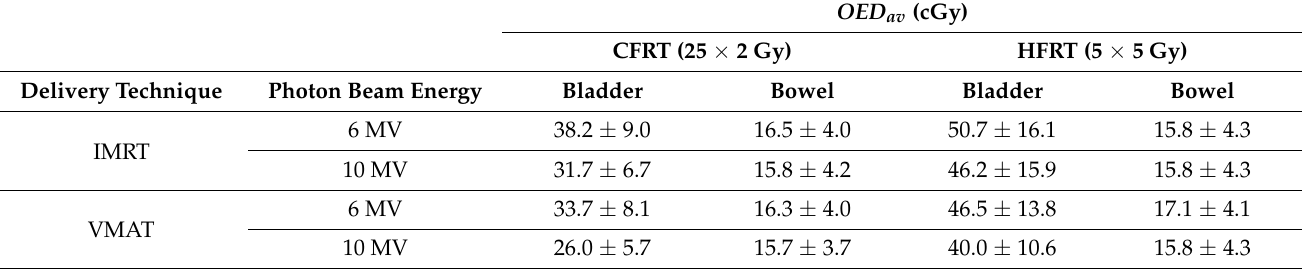
Table 5. (Average ± 1 standard deviation) Organ Equivalent Dose ( OED av ) calculations derived from CFRT (25 × 2 Gy) and HFRT (5 × 5 Gy) treatment plans for preoperative rectal cancer irradiation using IMRT and VMAT, and 6 MV or 10 MV photon beams.